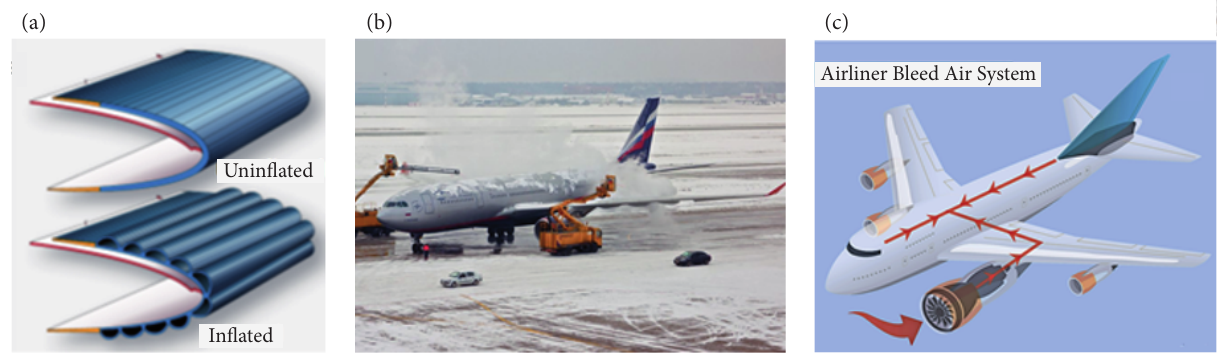
Figure 14. (a) Inflatable rubber boot method, (b) chemical spray method,